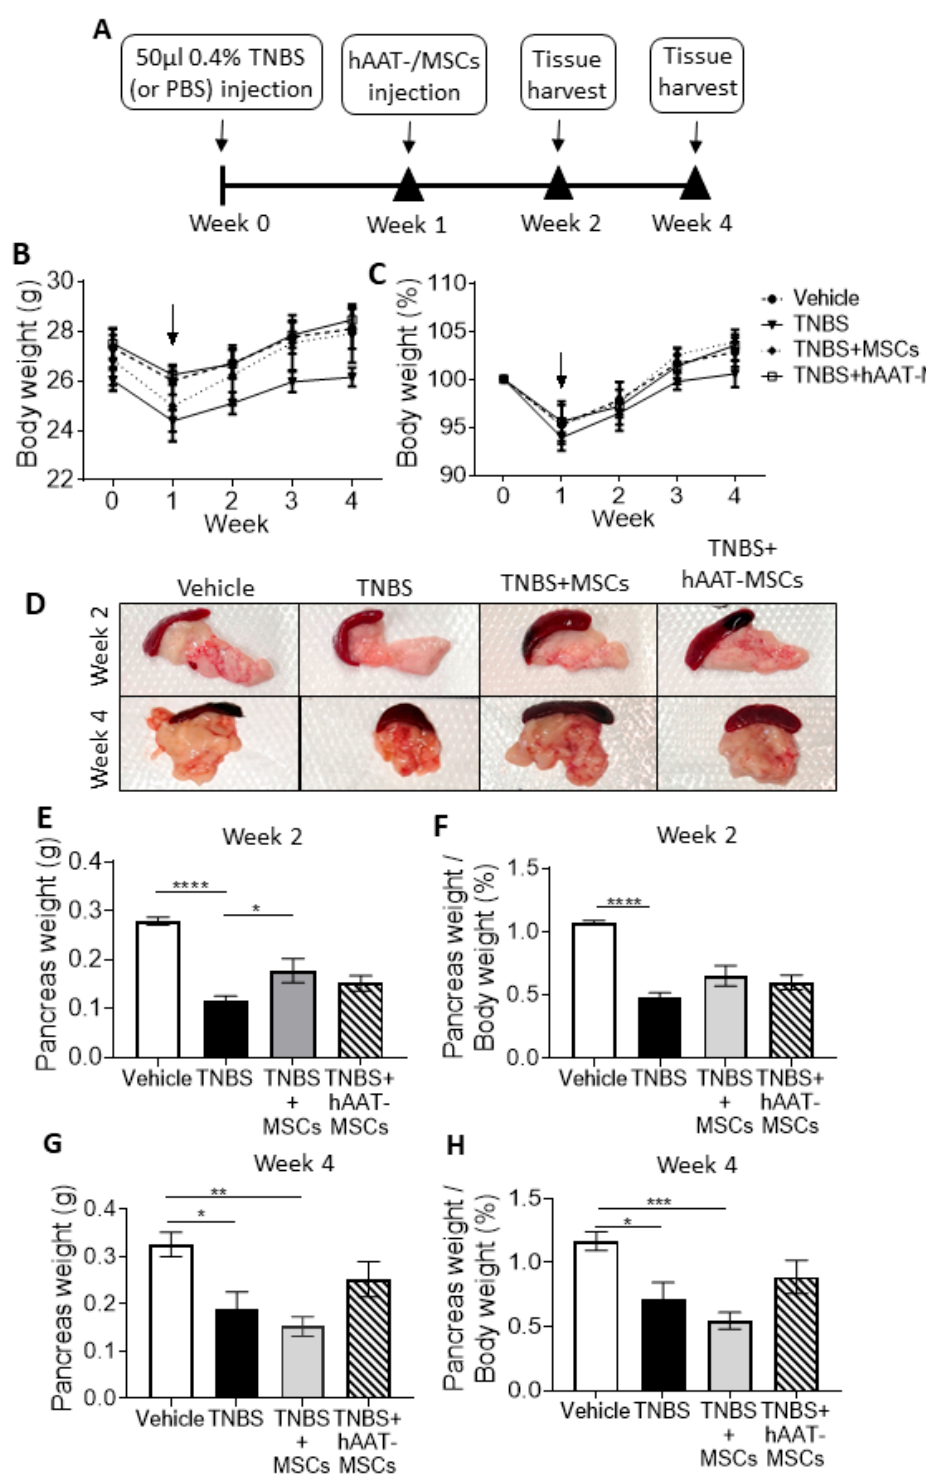
Figure 1. The effects of mesenchymal stromal cell (MSC) therapy on the body weight and pancreas weight of chronic pancreatitis (CP) mice. ( A ) Schematic diagram of CP induction by trinitrobenzene sulfonic acid (TNBS), cell infusion, and tissue collection and analysis. ( B , C ) Body weight changes represented in total body weight and percentage change. Arrow indicates the infusion of human alpha-1 antitrypsin-overexpressed mesenchymal stromal cells (hAAT-MSCs) or native MSCs (Vehicle = 6, TNBS = 8, TNBS + MSCs = 6, TNBS + hAAT-MSCs = 6 mice per group). ( D ) Images of pancreases collected from Vehicle, TNBS mice, or TNBS mice treated with MSCs or hAAT-MSCs 0.5 × 10 6 cells/mouse). ( E – H ) Pancreas weights and percent ratio of pancreas weight to body weight at ( E – F ) 2 week-(Vehicle = 7, TNBS = 8, TNBS + MSCs = 8, TNBS + hAAT-MSCs = 7 mice per group), and ( G , H ) 4 week post TNBS treatment. Scale bar = 1 cm. Data presented are mean ± SEM. One-way ANOVA and Tukey’s test were used. * p < 0.05, ** p < 0.01, *** p < 0.001, **** p <